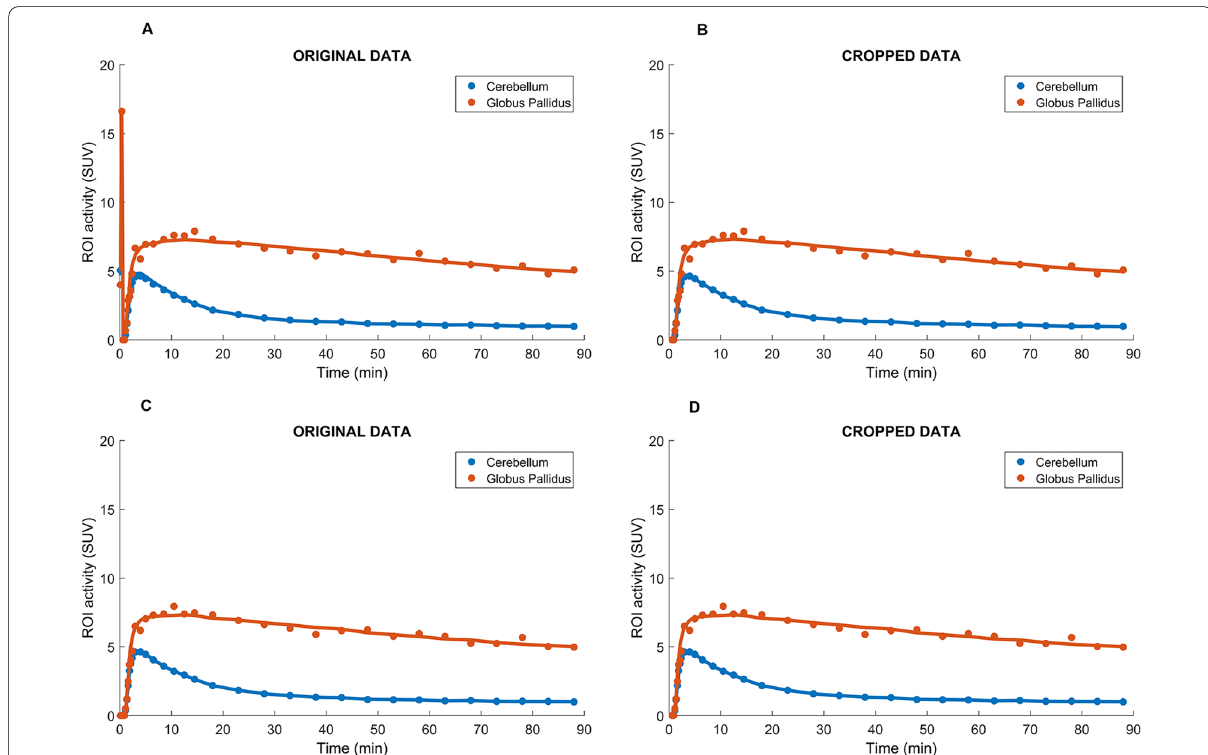
Fig. 1 Model fitting obtained for the Cerebellum and Globus Pallidus, one PET-MR brain dataset (same subject) reconstructed with TOF Q.Clear β 100 (top row) and OSEM (bottom row). Note the interference of the background counts on the model fitting on the graphic entitled “Original Data” ( A ). The three initial frames that contained background counts were removed on the graphic entitled “Cropped data” ( B ). Note the lack of interference from the background counts, when OSEM is used, on the model fitting on graphic ( C ) and the similar model fitting obtained when the initial frames are removed for the OSEM reconstructed, on graphic ( D